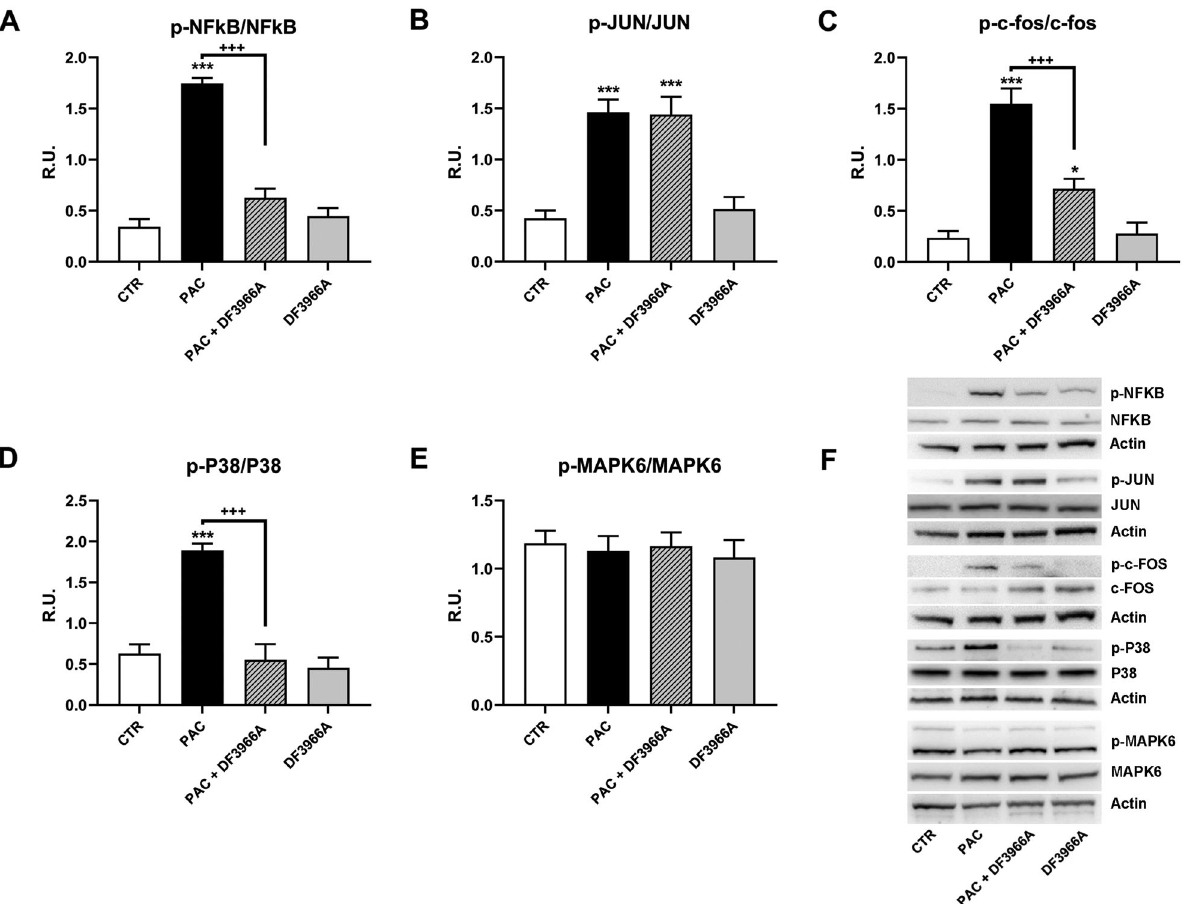
Fig. 3 Paclitaxel-C5aR1 intracellular pathway. Quanti fi cation of the expression of phosphorylated and total forms of NF κ B ( A ), c-Jun ( B ), c-Fos ( C ), p38 MAPK ( D ) and ERK3/MAPK6 ( E ) in differentiated F11 cells following paclitaxel (PAC) treatment evaluated by western blot analysis ( F ). F11 cells were treated for 24 h with PAC (10 nM) and DF3966A (10 µM). *** P < 0.0005; * P < 0.05 vs CTR; +++ P < 0.0005 vs paclitaxel. Data are mean ± SEM of n = 3 different